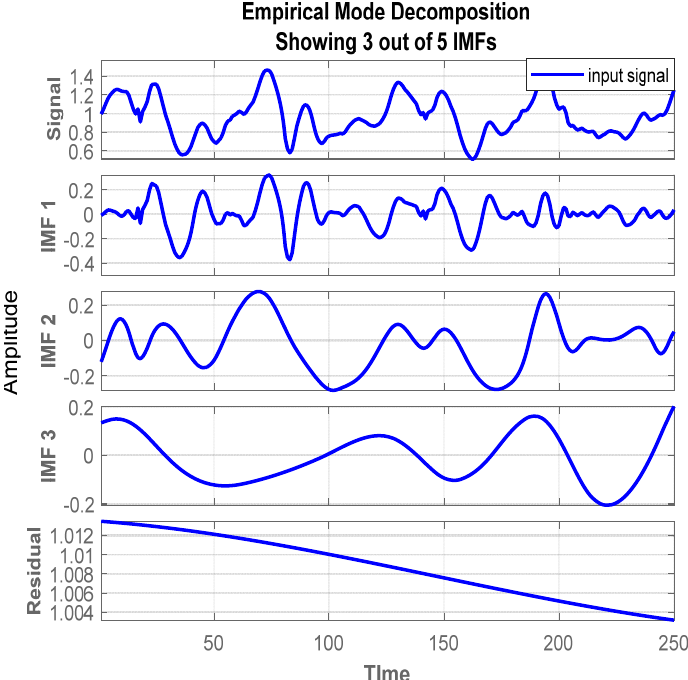
Figure 4. The sifting process of the empirical mode decomposition of inertial components from the USC − HAD dataset. From top to bottom, an input signal and intrinsic mode functions 1, 2, and 3. Finally, IMF is reduced from the input.